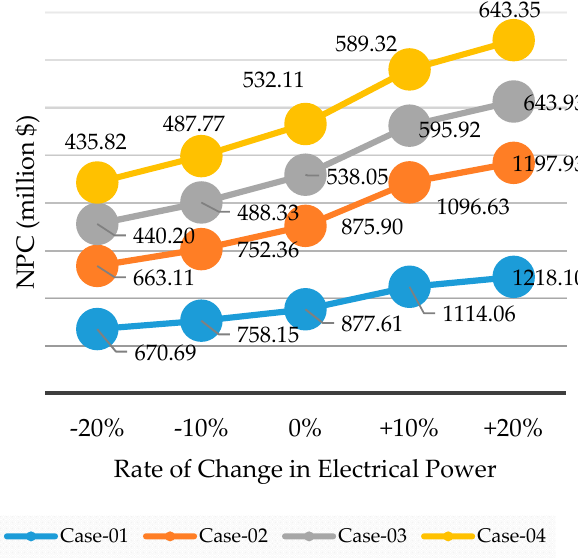
Figure 17. Sensitivity Assessment of Electrical Power Requirement on NPC.